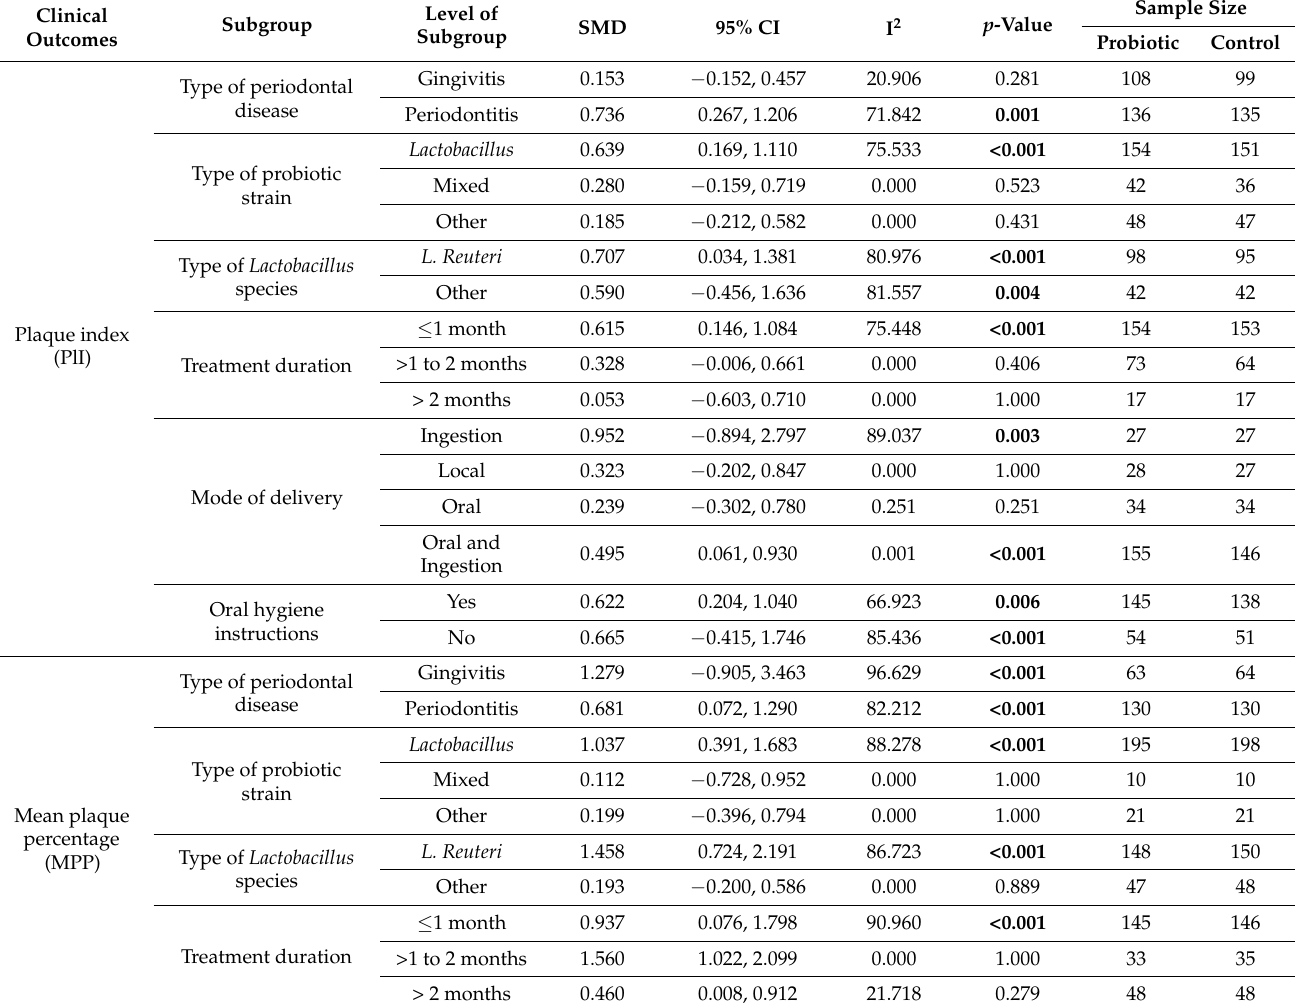
Table 2. Subgroup analysis examining the effects of probiotic supplementation on clinical